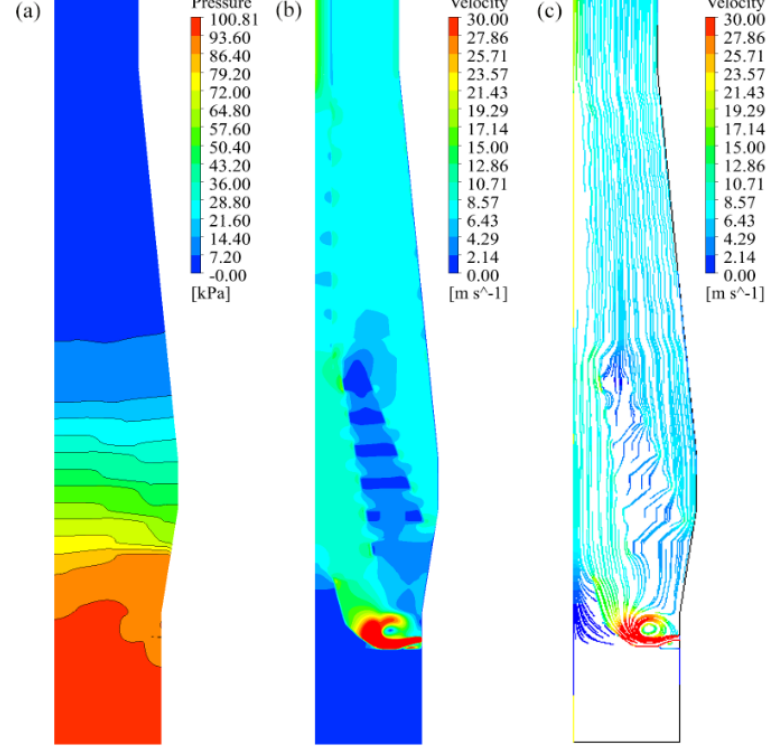
Figure 5. Contour and path line of traditional BF (with central coke, R = 50%, γ = 60 ◦ , n = 6): ( a ) pressure contour, ( b ) velocity contour, and ( c ) path line.